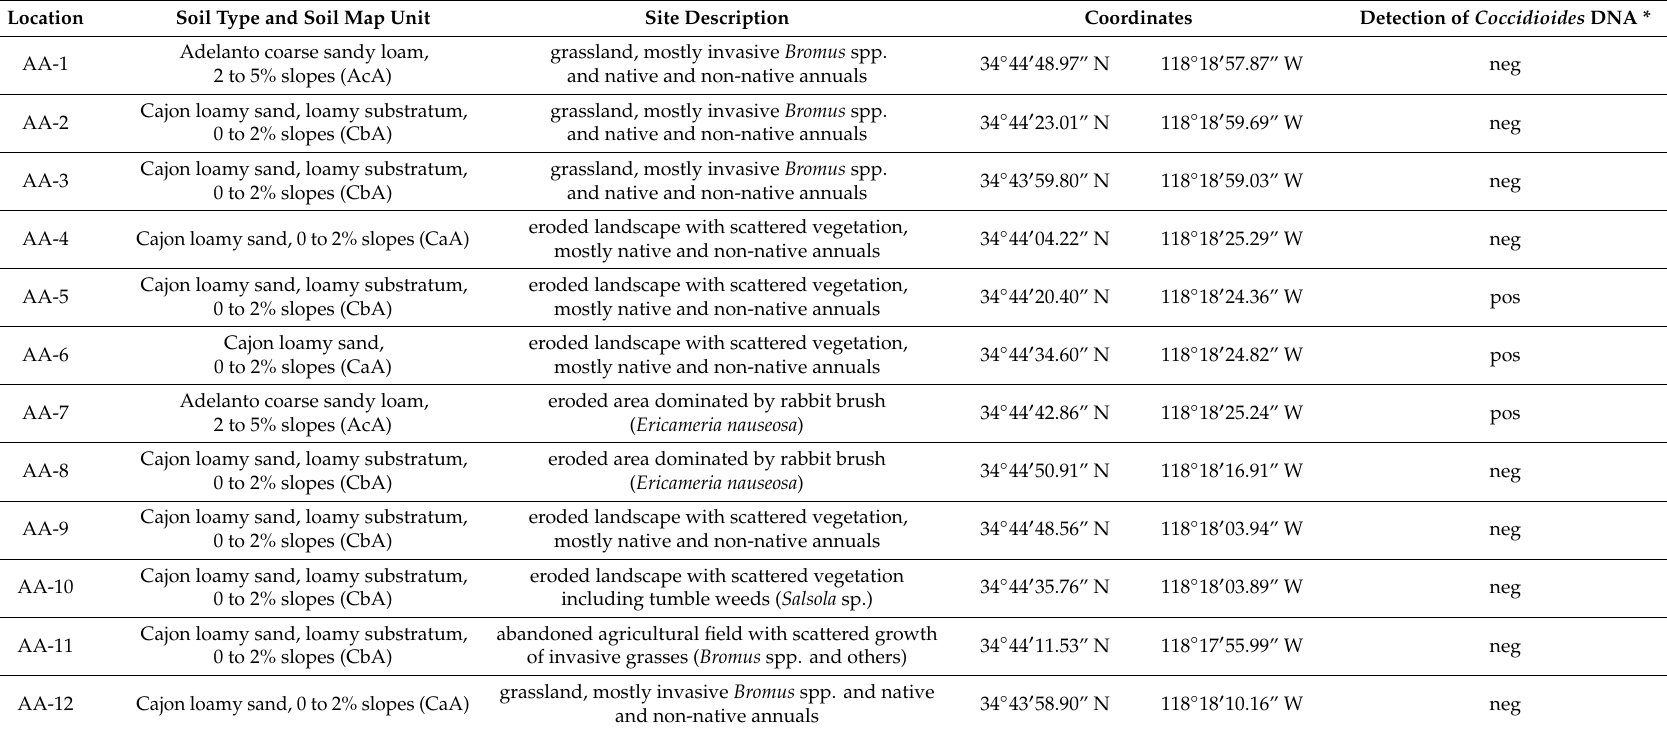
Table 3. Results of Coccidioides DNA testing at sampling sites west of Edwards AFB adjacent to Antelope